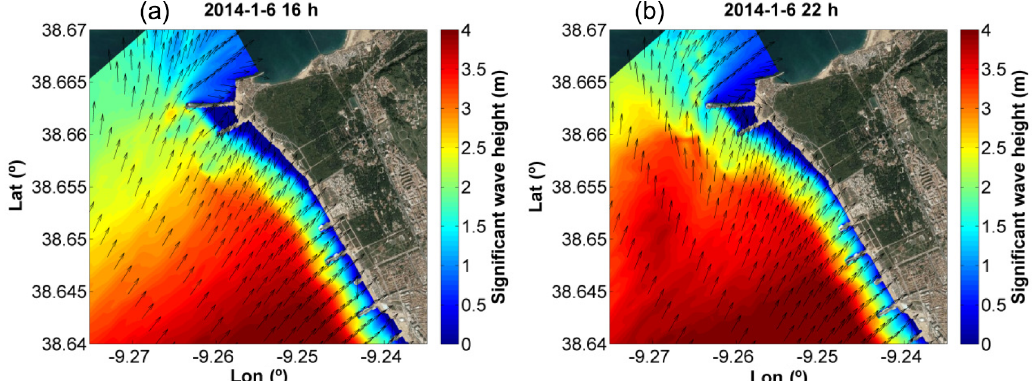
Figure 13. Wave results of the Costa da Caparica